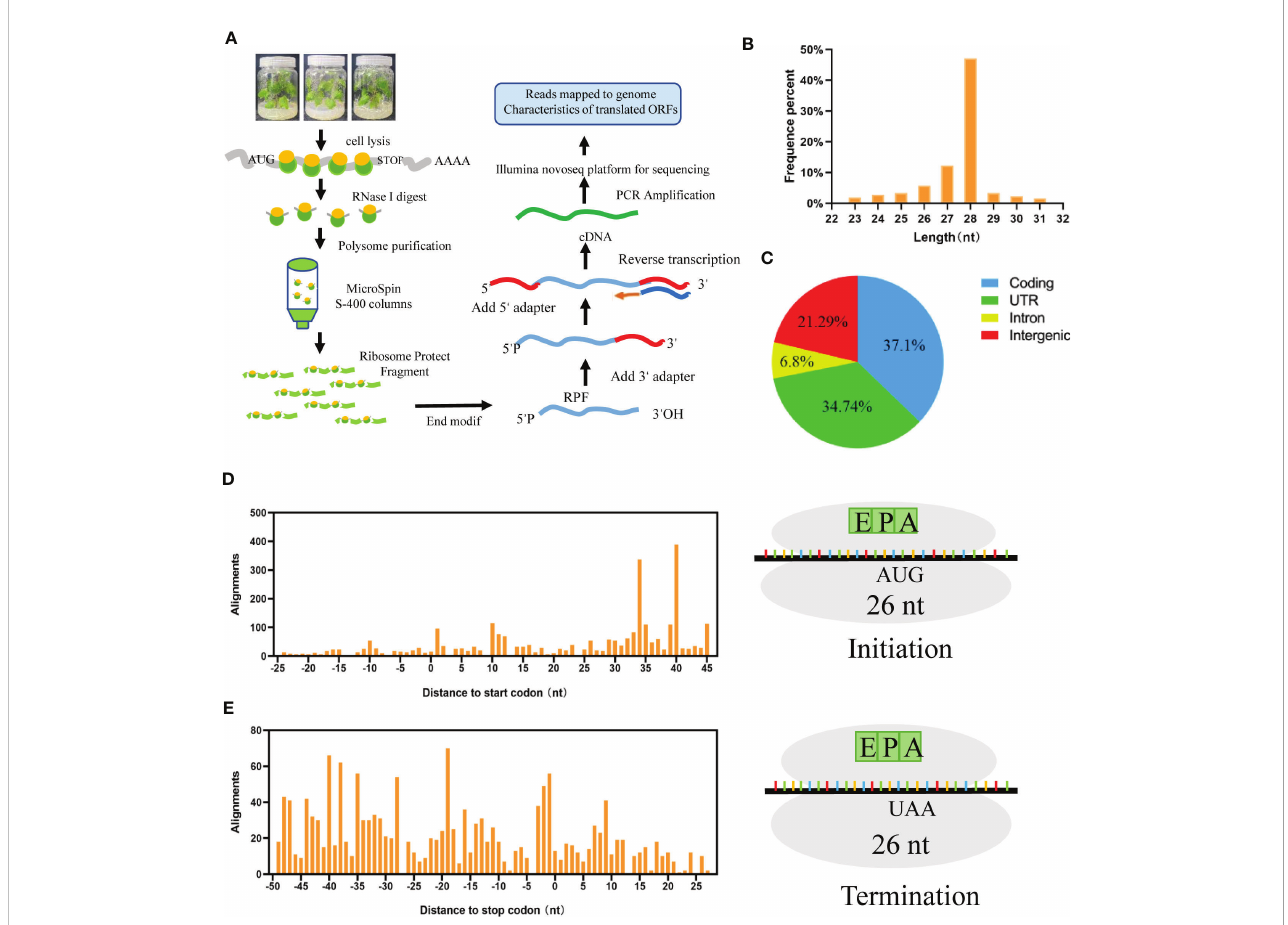
FIGURE 1 Translation landscape in grapes. (A) Overview of the ribosome sequencing approach, the mRNA-tethered ribosomes were extracted and enriched, which performed library preparation and deep sequencing. (B) mRNA protected by ribosome fragment enriched at 23-31nt. (C) Protein translation regions are distributed in coding, UTR, Intron and Intergenic. (D) Ribosomes move in units of 3 nt nucleotides in the initial codon. (E) Ribosomes move in units of 3 nt nucleotides in a stop